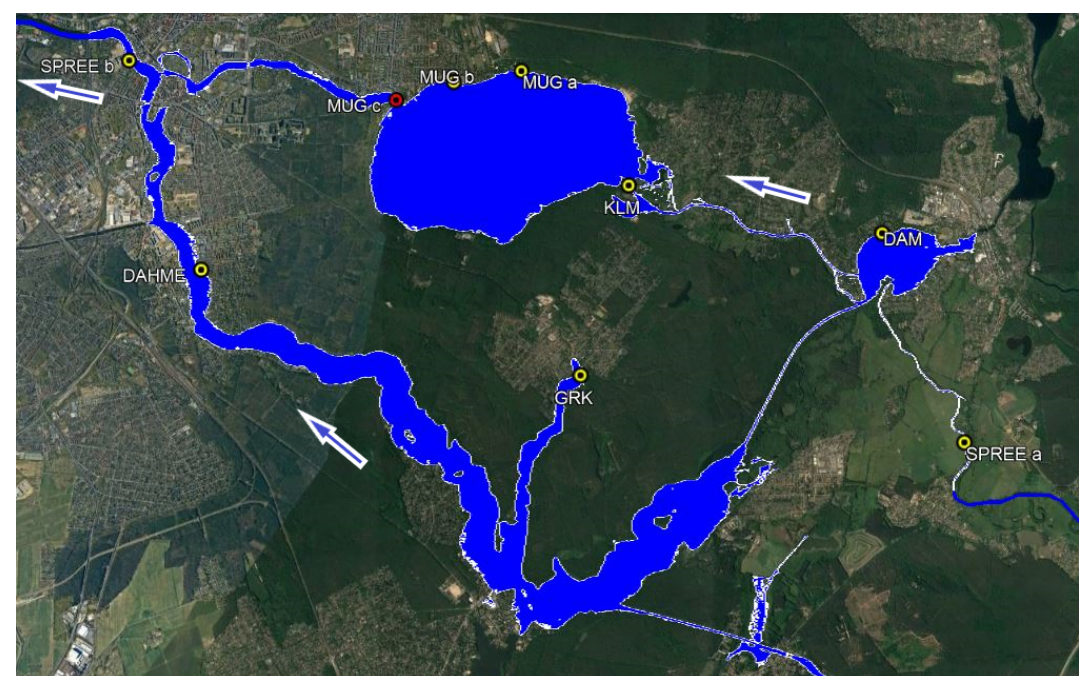
Figure 3. Sampling locations at the Spree–Dahme (SE Berlin). Time series samples from the Müggelsee outflow in red. Arrows indicate stream direction. Underlying map © Google Earth 2021.